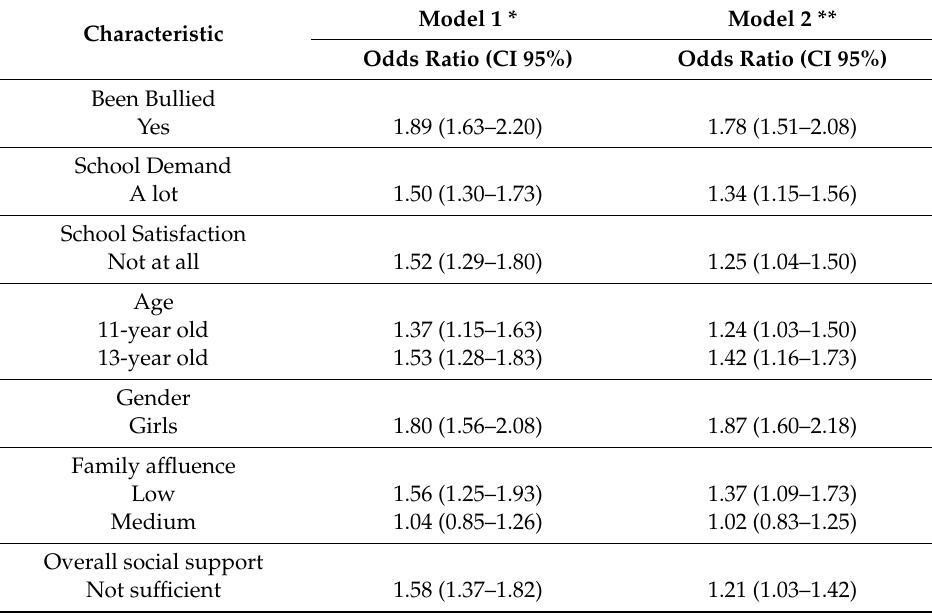
Table 6. Multisite complaints and associated factors: logistic regression